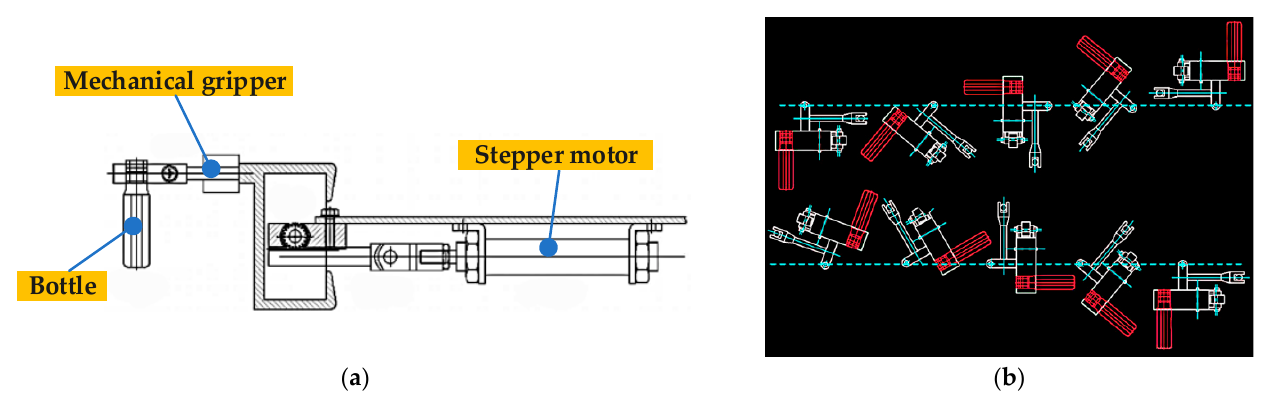
Figure 1. Diagrams of the flipping mechanism and the flipping process of a bottled Baijiu. ( a ) The flipping device; ( b ) The flipping process of bottled Baijiu.